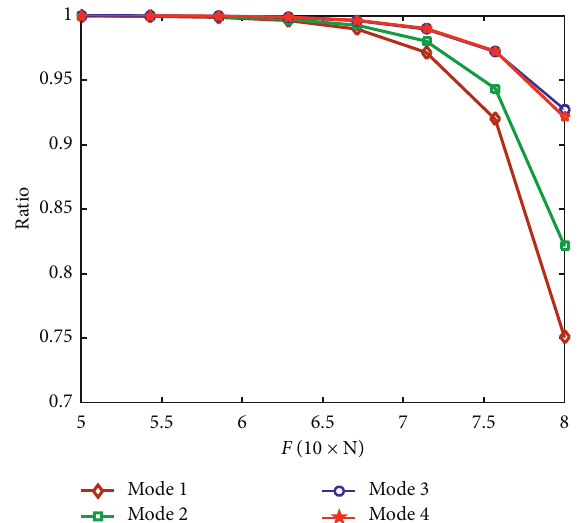
Figure 6: The first four natural frequencies under various thrust forces with F-C boundary